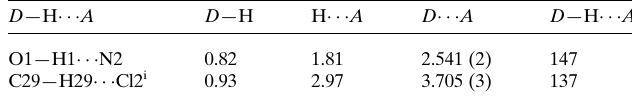
Table 1 Hydrogen-bond geometry (A˚ , (cid:2) ).